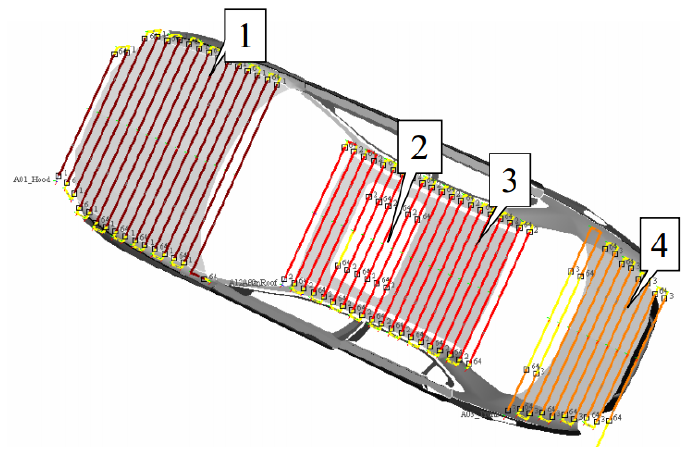
Figure 14. Optimized trajectory on the roof part of the automobile.